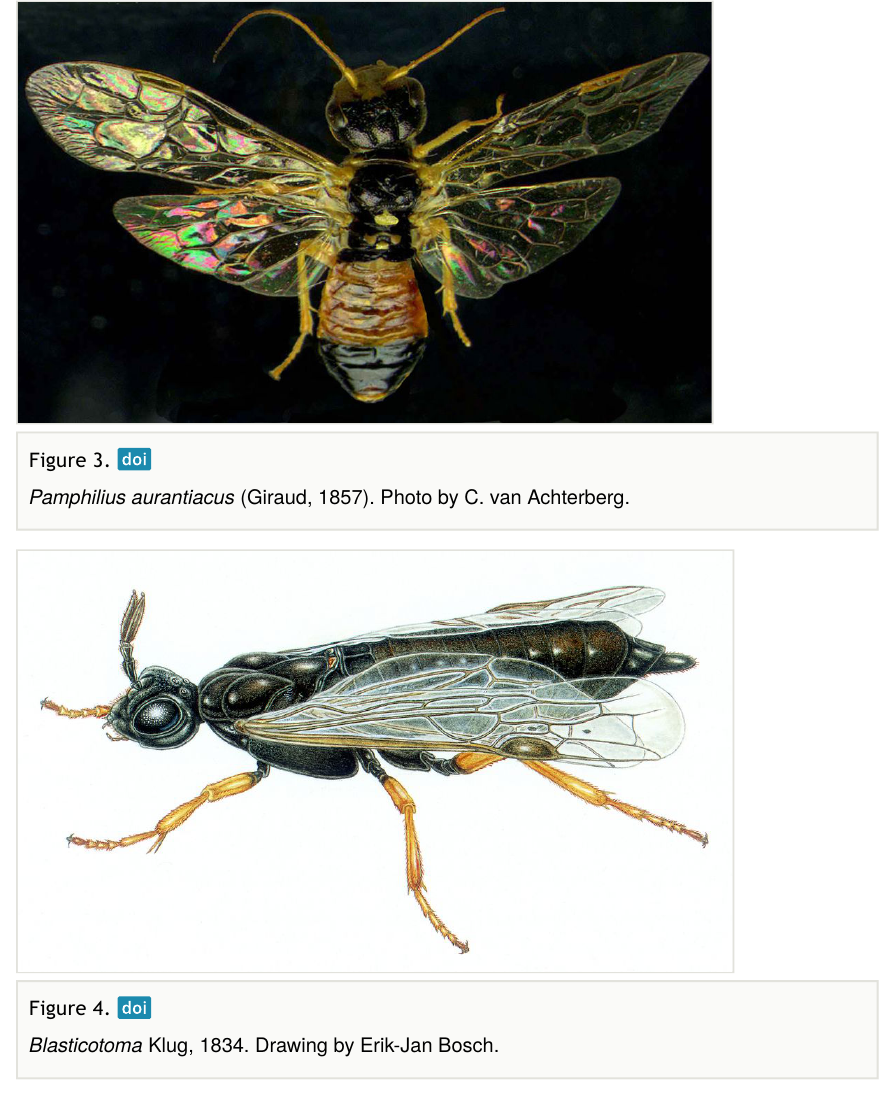
Argidae: Medium -sized cosmopolitan family; the larvae of Arginae live especially on Rosaceae, but also catkin-bearing trees (Salicaceae, Fagaceae) and Proteaceae are used. Larvae of some Sterictiphorinae live on herbaceous Fabaceae. The males in the subfamily Sterictiphorinae may have the third antennal segment branched. Tenthredinidae: Large and very diverse cosmopolitan family containing most species of Symphyta in the Holarctic region. The larvae live on or mine on many kinds of trees, shrubs or herbaceous plants, including fruits, ferns, horse-tails ( Equisetum spp.) and rushes ( Juncus species) (Fig. 5, Fig. 6).